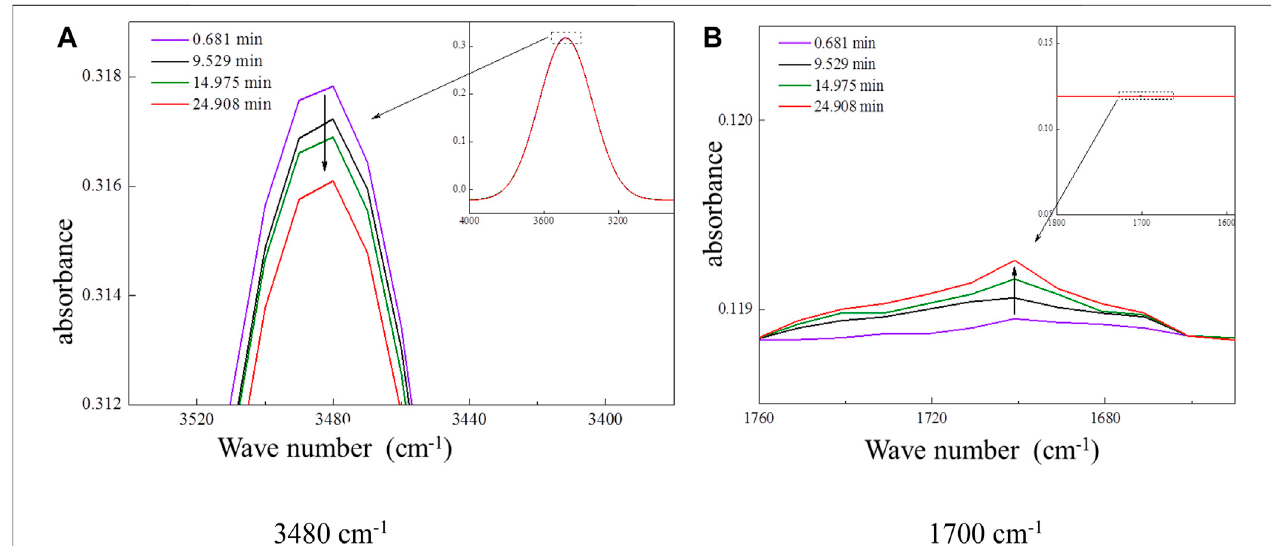
FIGURE 4 | Changes of the AME absorption peak at 3,480 and 1700 cm − 1 in the course of reactions. (A) 3,480 cm − 1 (B) 1700 cm − 1 .